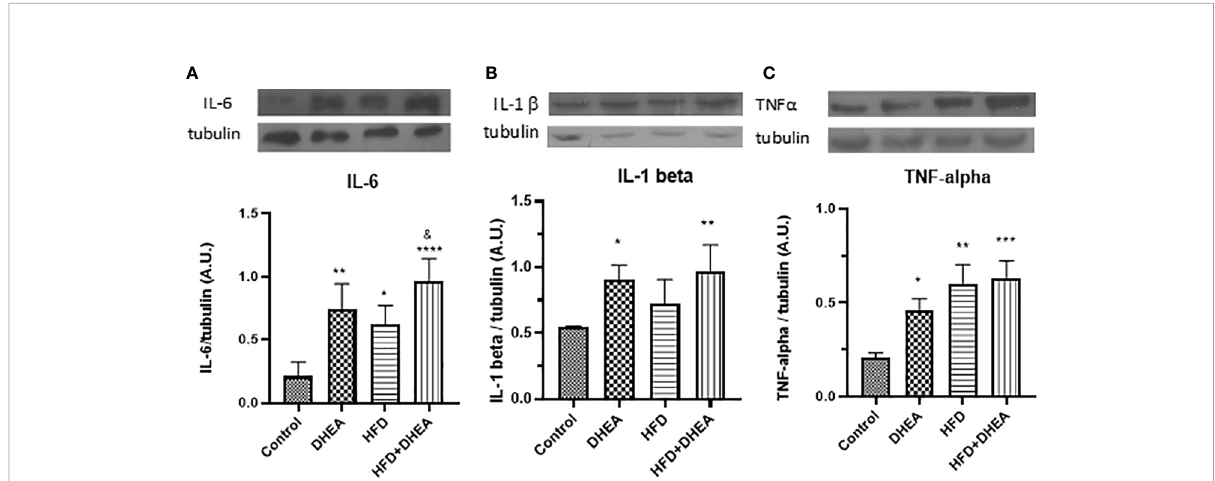
FIGURE 3 Expression of in fl ammation mediators. Protein levels of IL-6 (A) , IL-1 b (B) , and TNF- a (C) were determined by Western blot in lung homogenates. Representative immunoblots of three experiments in duplicate and graphical representations of protein expressions normalized to b -tubulin are shown. * p < 0.05, ** p < 0.01, *** p < 0.001 **** p < 0.0001 versus C and & p < 0.05 versus HFD.